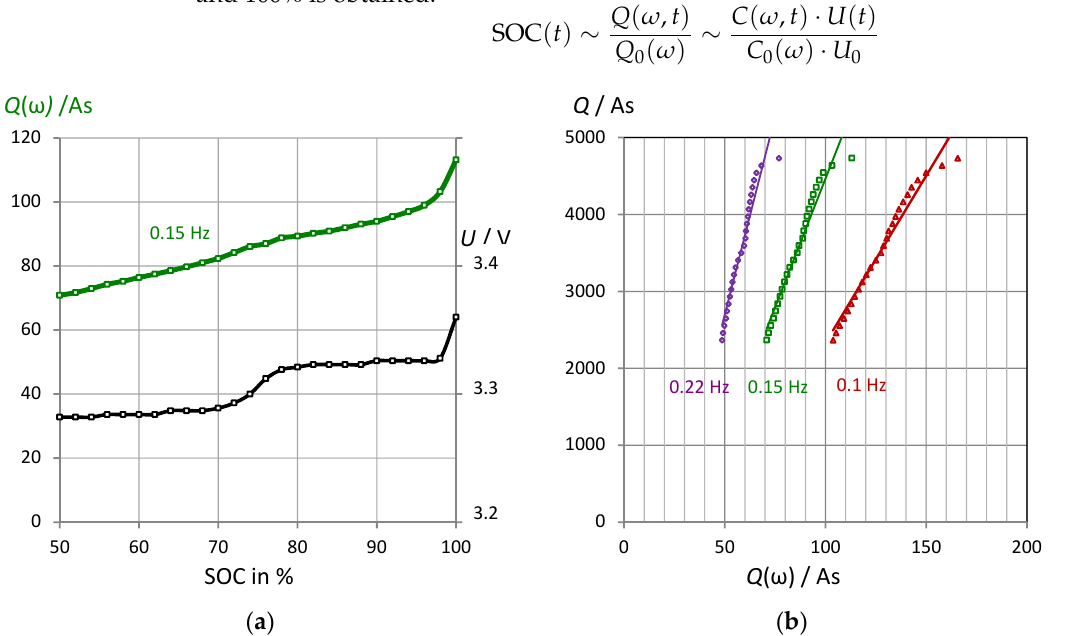
Figure 6. VoltSolar LFP battery. ( a ) Pseudocharge Q (0.15 Hz) = C (0.15 Hz) ⋅ U and cell voltage U versus the “true” state-of-charge Q measured by Ah counting. ( b ) Linear correlation between pseudocharge Q ( ω ) and “true” battery capacity at different discharge states. Example: Q /As = 66.92 ⋅ Q (0.15 Hz) − 2226. LPF batteries from different manufacturers show qualitatively the same results.